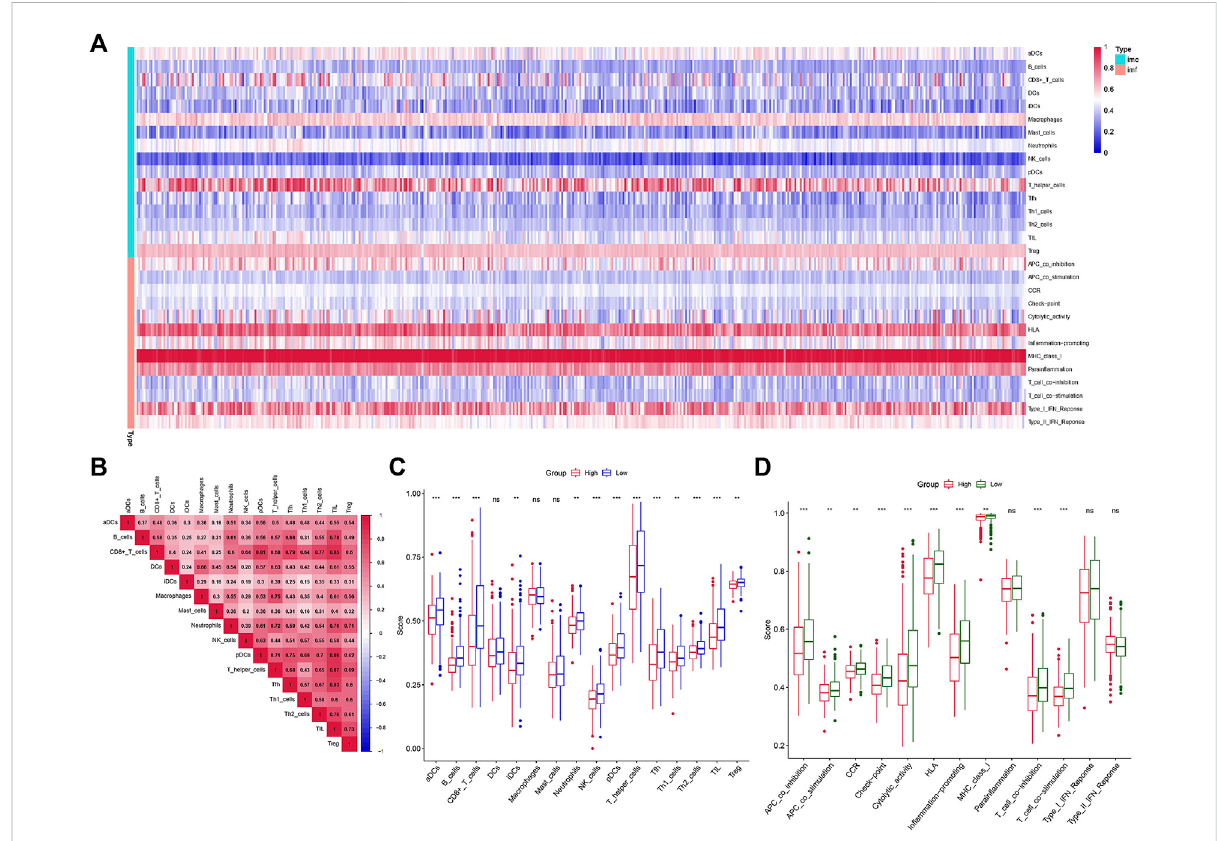
FIGURE 6 Immune function analysis. (A,B) The heatmap of immunocorrelation analysis. (C,D) Immune differential analysis and functional differential analysis between the high- and low-risk score